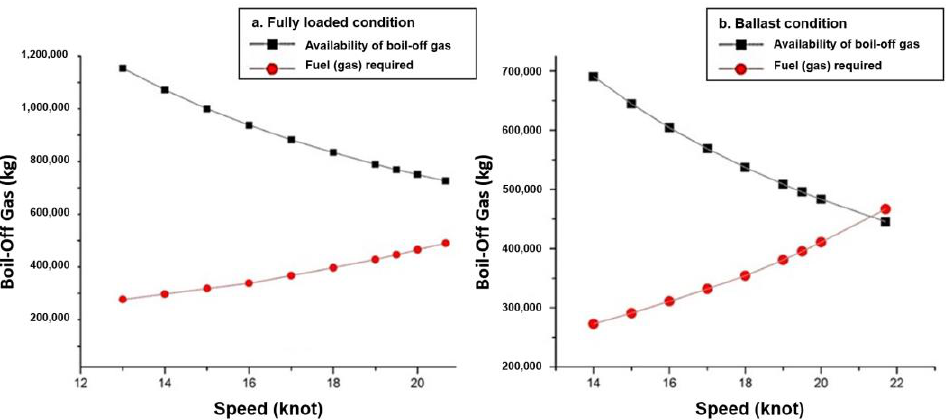
Figure 10. Availability of boil-off gas and fuel requirements of ships at the time of fully loaded condition ( a ) and ballast condition ( b ).